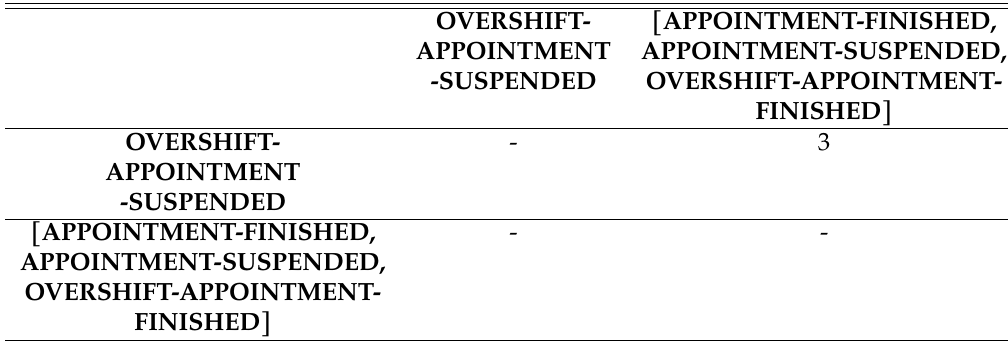
Table 6: Matrix of distances between elements after the first